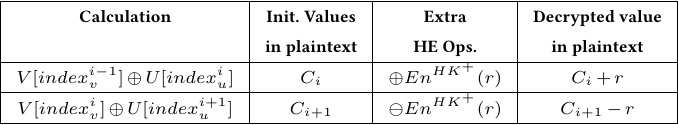
Figure 7. Malicious deletion attack